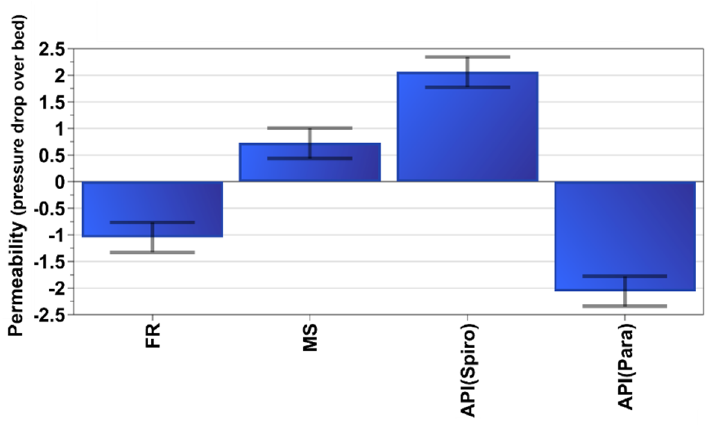
Figure 4. Coefficient plot for permeability. FR = Feed rate, MS = Mixer impeller speed.